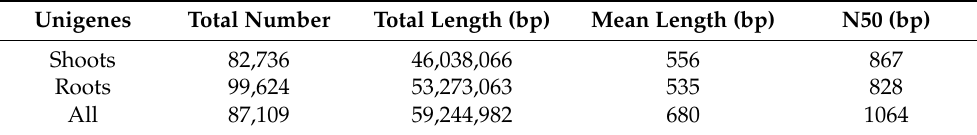
Table 1. Overview of de novo assembly of transcriptome sequence.